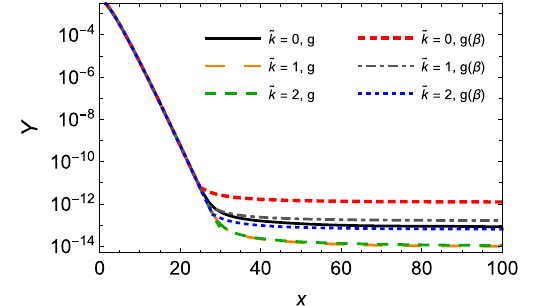
Fig. 7 The relic abundance Y ( x ) for spin-half monopole as a function of x = M / T , according to Eq. (13), at the fixed value of the monopole mass M = 5 TeV, but taking a velocity (β) dependent coupling, g (β) , and different values of the normalized parameter ˜ κ = κ M